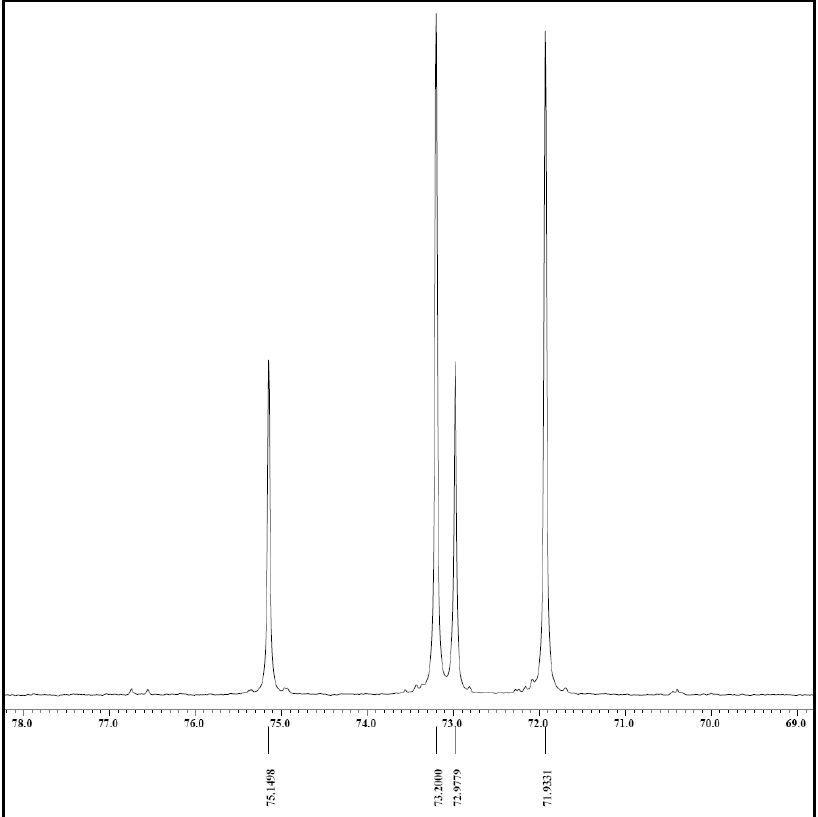
Figure 7. 13 C-NMR spectrum obtained from analysis on myo -inositol crystals isolated from red dragon